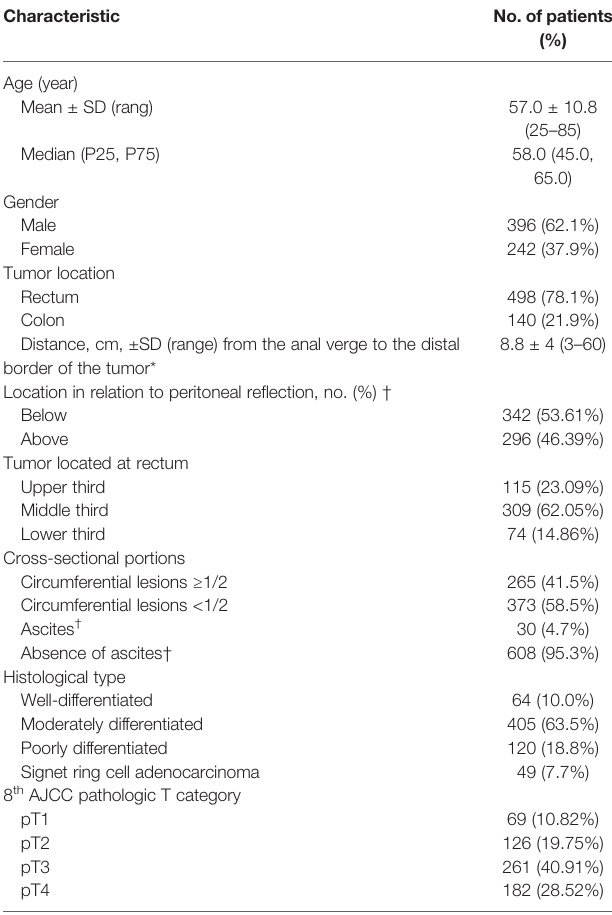
TABLE 2 | The Basic clinicopathological characteristics of the patients and tumors. Characteristic No. of patients